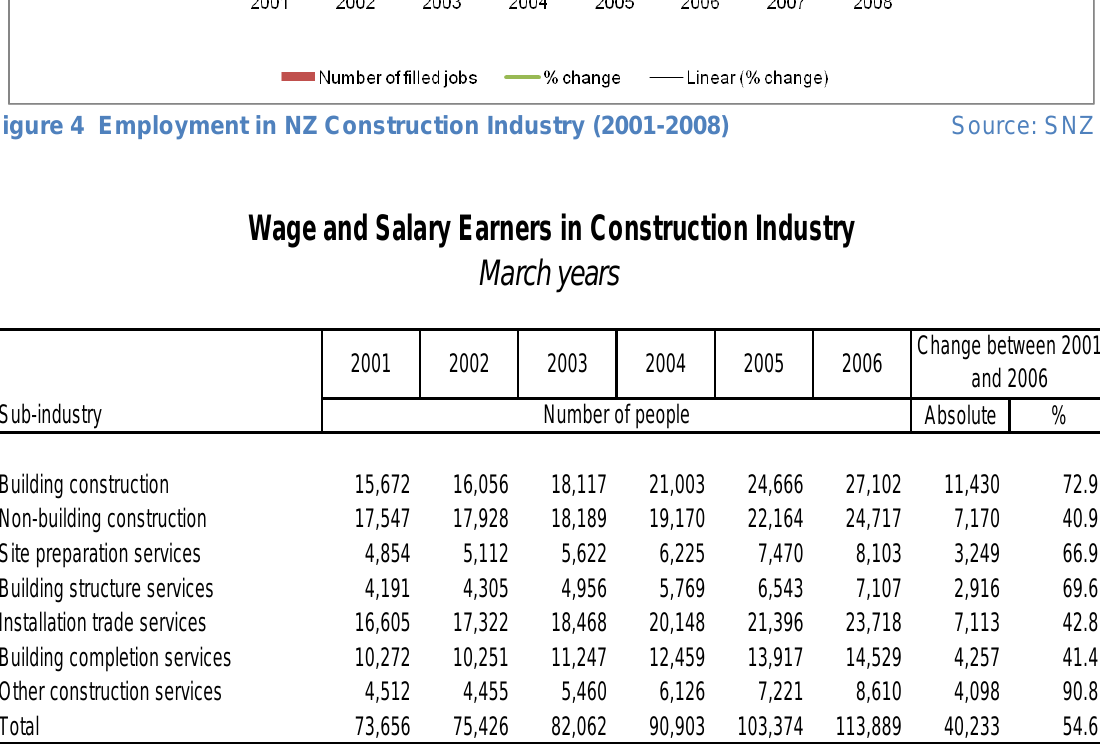
Table 4 Wage and Salary Earners in Construction Industry Source: